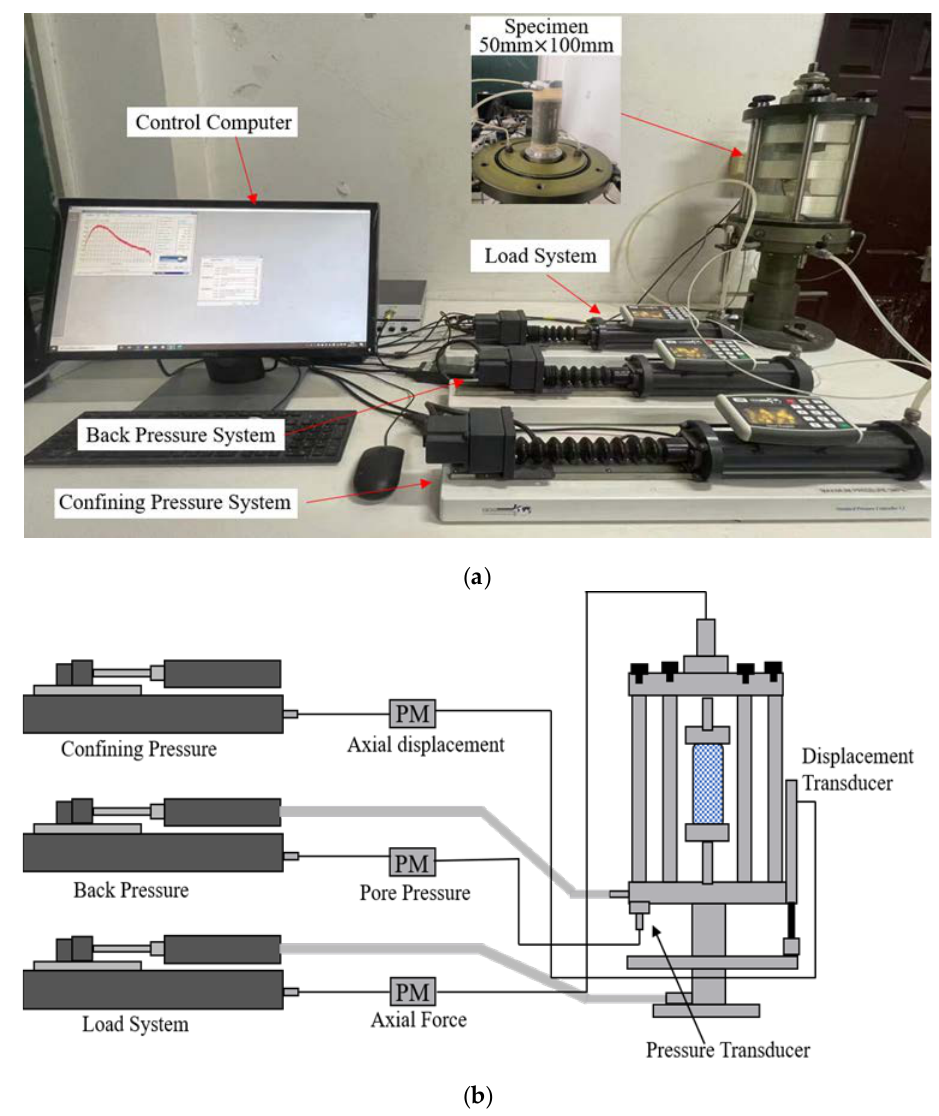
Figure 2. GDS Triaxial testing system. ( a ) Physical apparatus; ( b ) Schematic diagram.